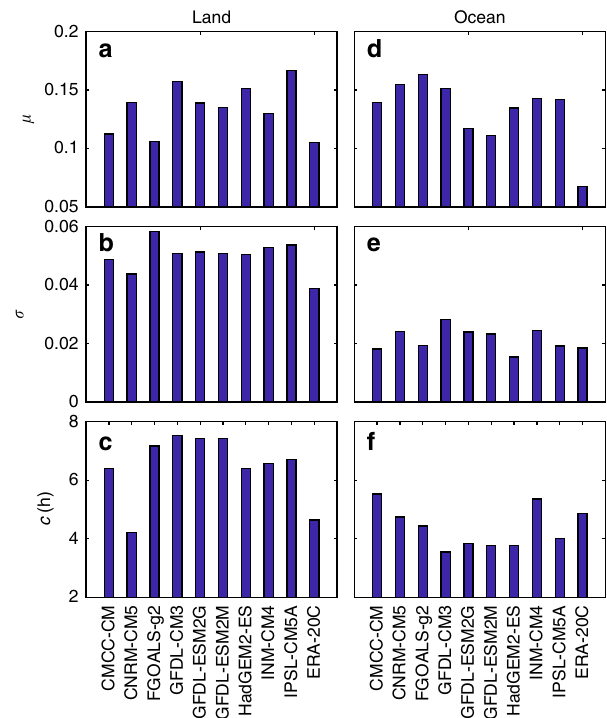
Fig. 2 Root-mean-square deviation of DCC indexes between satellite observations and climate model outputs. a , d RMSD of mean cloud coverage, μ , over the land and ocean; b , e RMSD of cloud coverage standard deviation, σ , over the land and ocean; c , f RMSD of the cloud coverage centroid, c , over the land and